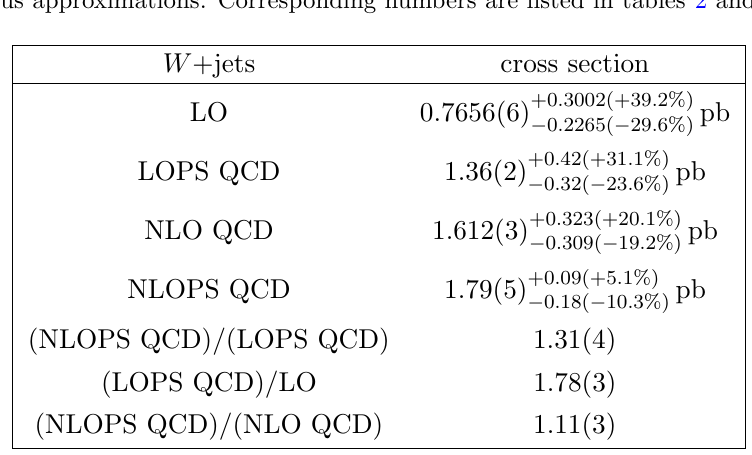
Figure 7 . Single-Top cross section and their uncertainty from scale dependence in the (cid:12)ducial region in various approximations. Corresponding numbers are listed in tables 2 and 3.